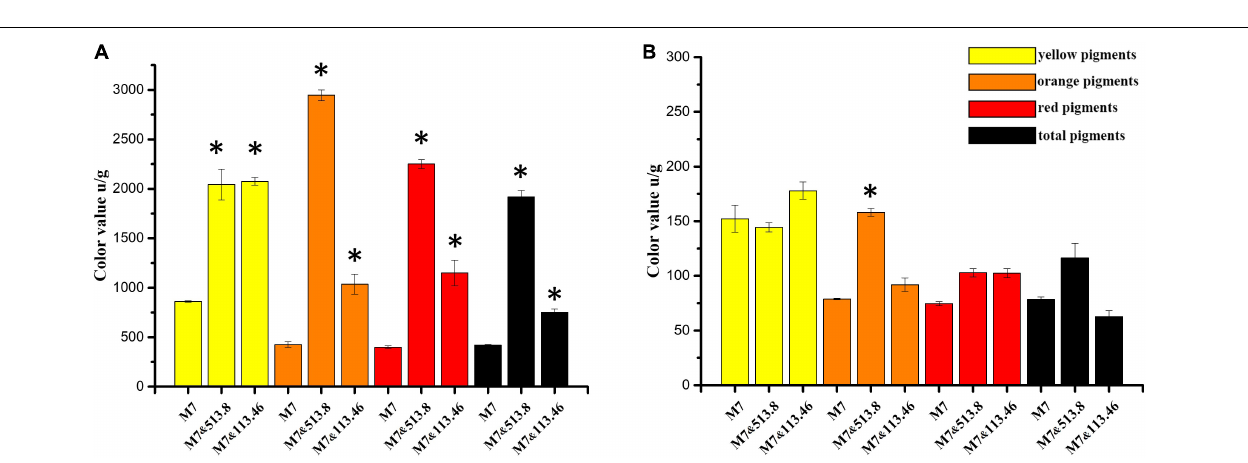
FIGURE 7 | Color value variation of Monascus spp. and Aspergillus niger cocultivation: (A) comparison of Monascus ruber M7 intracellular (mycelia) color value among monoculture, co-cultured with A. niger CBS 513.88 and co-cultured with A. niger CBS 113.46; (B) comparison of M. ruber M7 extracellular (media) color value among monoculture, co-cultured with A. niger CBS 513.88 and co-cultured with A. niger CBS 113.46. Abbreviations: M7-monocultured M. ruber M7; M7&513.88- M. ruber M7 co-cultured with A. niger CBS 513.88; M7&113.46- M. ruber M7 co-cultured with A. niger CBS 113.46. *Represents significant difference compared with control ( P <